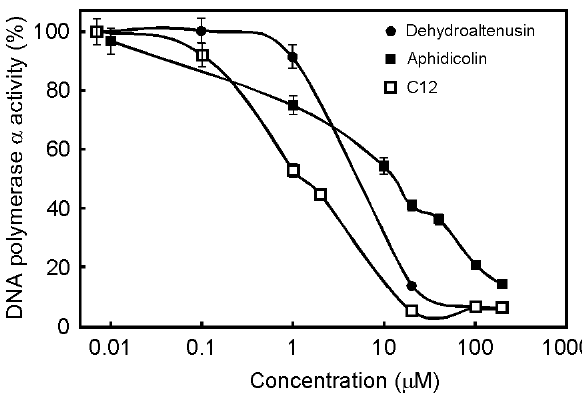
Figure 2. Dose-response curves of dehydroaltenusin, C12 and aphidicolin with DNA polymerase α inhibition. Effects of dehydroaltenusin (closed circle), C12 (open square) or aphidicolin (closed square) on the activities of calf thymus pol α are shown. Amount of enzyme in the assay mixture was 0.05 units. Pol α activity in the absence of the compounds was taken as 100%. Values are shown as the means ± S.E. for three independent experiments.